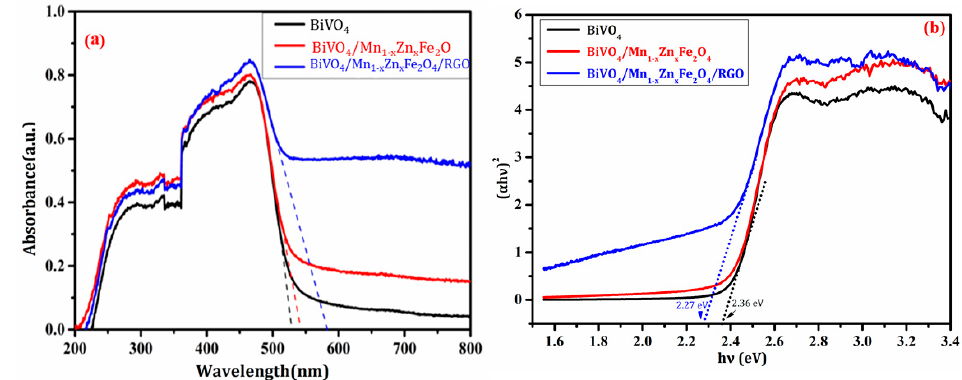
Figure 7. UV–vis diffuse reflectance spectra of the as-prepared products ( a ) and corresponding the plot of (Ah υ ) 1/2 versus h υ ( b ).